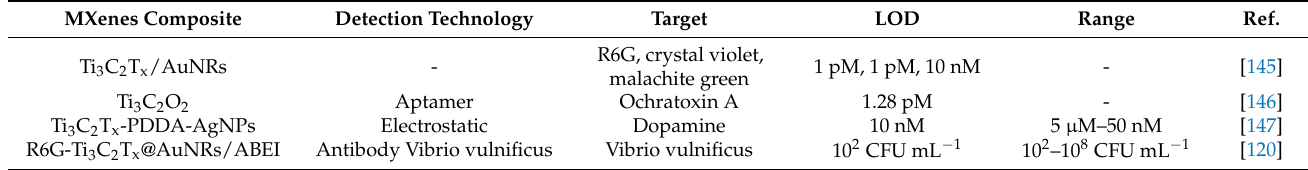
Table 8. MXene-based other biosensors identify units, target, and analytical parameters.